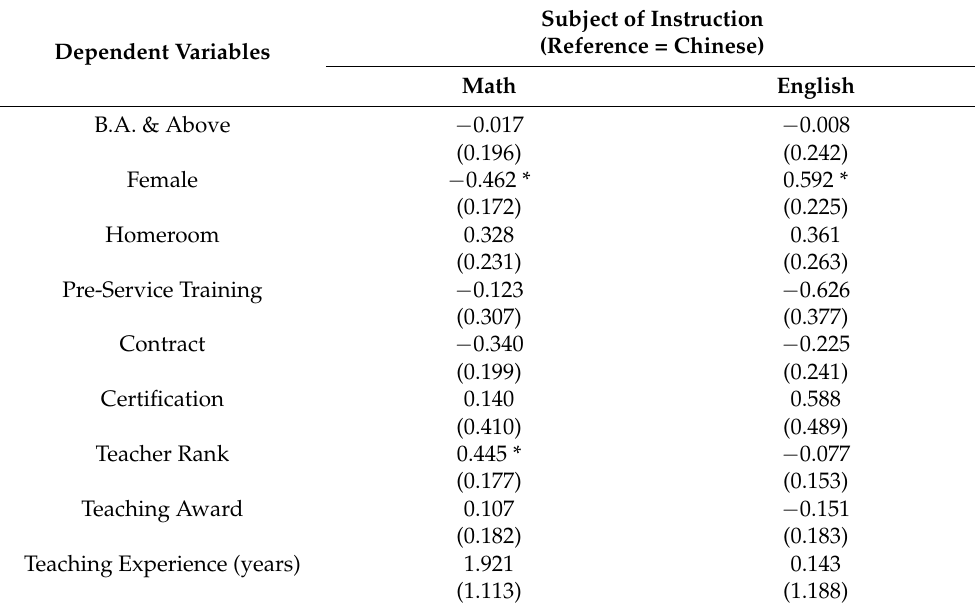
Table 6. Teacher characteristics by subject of instruction (N =